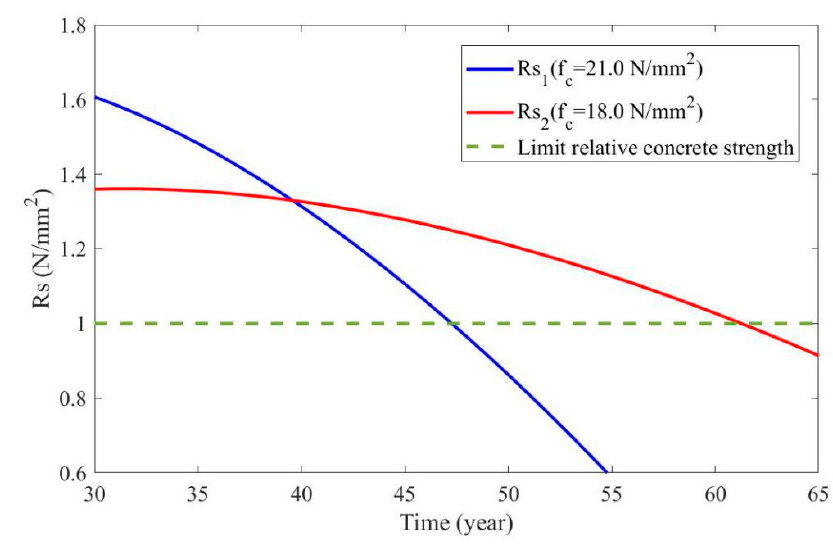
Figure 7. Relative concrete strength ( f c = 18.0N/ mm 2 and f c = 21.0 N/mm 2